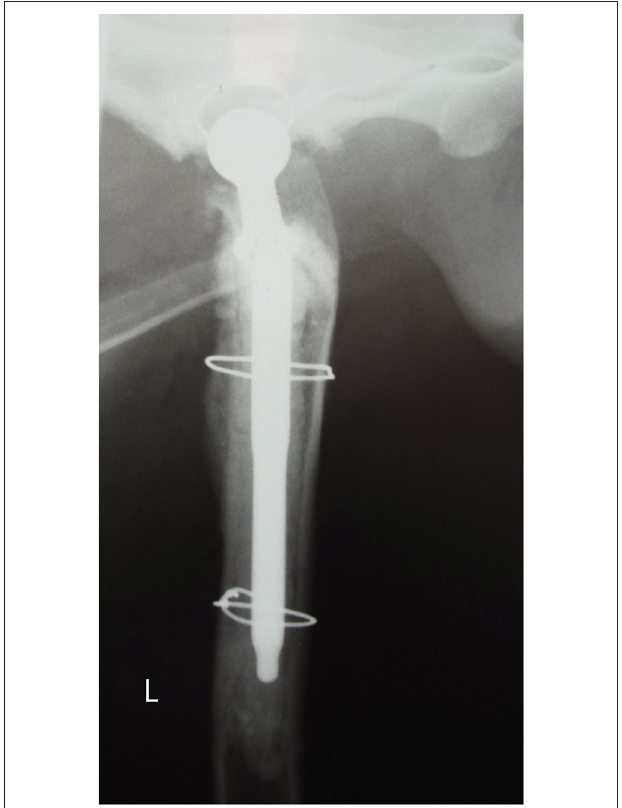
FIGURE 4 | Lateral radiograph 6 months after reimplantation. Proper positioning of the stem and periosteal reaction is